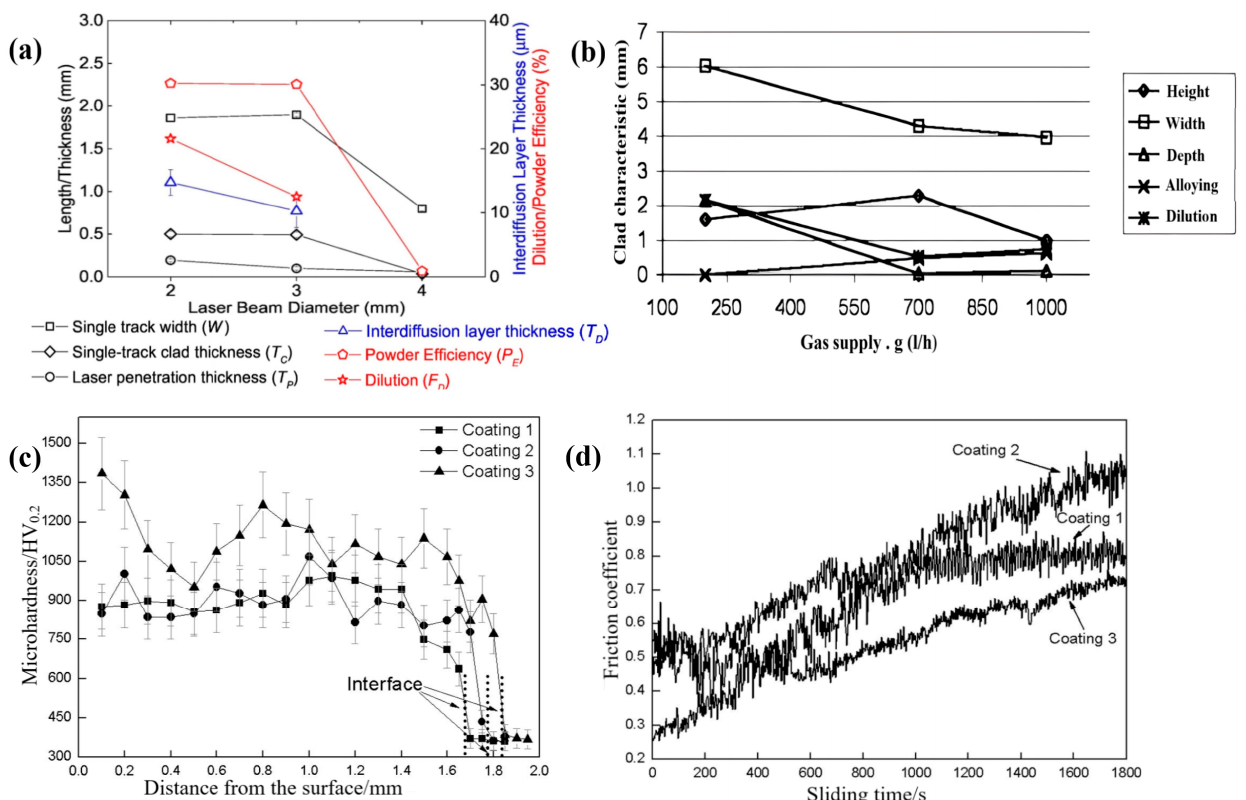
Figure 2. Influence of different laser beam diameters, gas supply speeds, and pre-coating thicknesses on cladding results. ( a ) Effect of different laser beam diameters on cladding results. Reprinted with permission from Ref. [64]. 2017, Elsevier. ( b ) The influence of different gas supply speeds on cladding results. Reprinted with permission from Ref. [65]. 2002, Elsevier. ( c ) Microhardness distribution along the depth direction of the coating under different pre-placed powder layer thicknesses. Reprinted with permission from Ref. [66]. 2015, Elsevier. ( d ) Variation in coating friction coefficient with sliding time for different pre-placed powder layer thicknesses. Reprinted with permission from Ref. [66]. 2015, Elsevier.